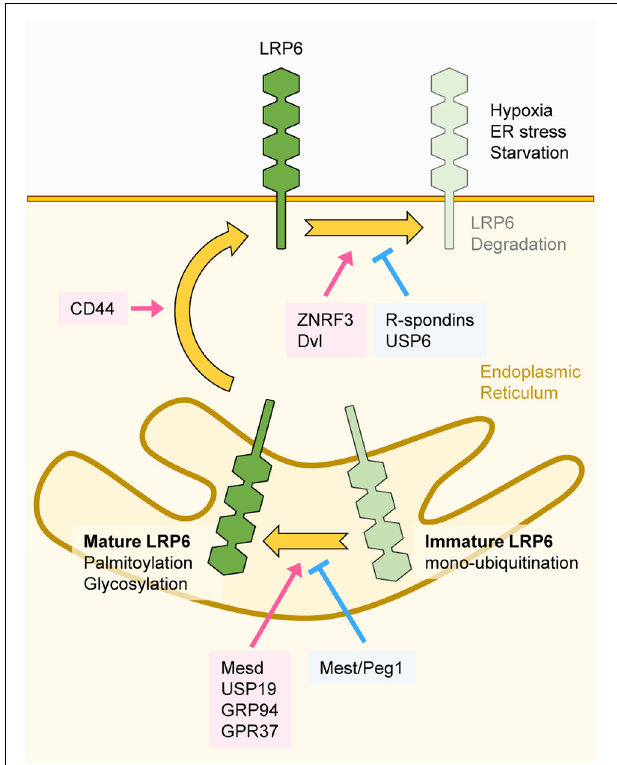
FIGURE 4 | Regulation of LRP6 maturation and stability. The transmembrane protein LRP6 undergoes several folding and maturation processes to translocate to the plasma membrane and properly function as a Wnt co-receptor. Mesd, USP19, GRP94, and GPR37 promote proper folding of LRP6. Glycosylation and palmitoylation of LRP6 are essential for its maturation. Mest/Peg1 inhibits glycosylation of LRP6 and immature LRP6 is mono-ubiquitinated, resulting in ER retention. Folded and mature LRP6 localizes to the plasma membrane, and CD44 promotes membrane localization of LRP6. ZNRF3 and DVL downregulate LRP6 protein levels, and USP6 and R-spondins antagonize ZNRF3 function. Extracellular stimuli such as hypoxia, ER stress, and starvation also degrade